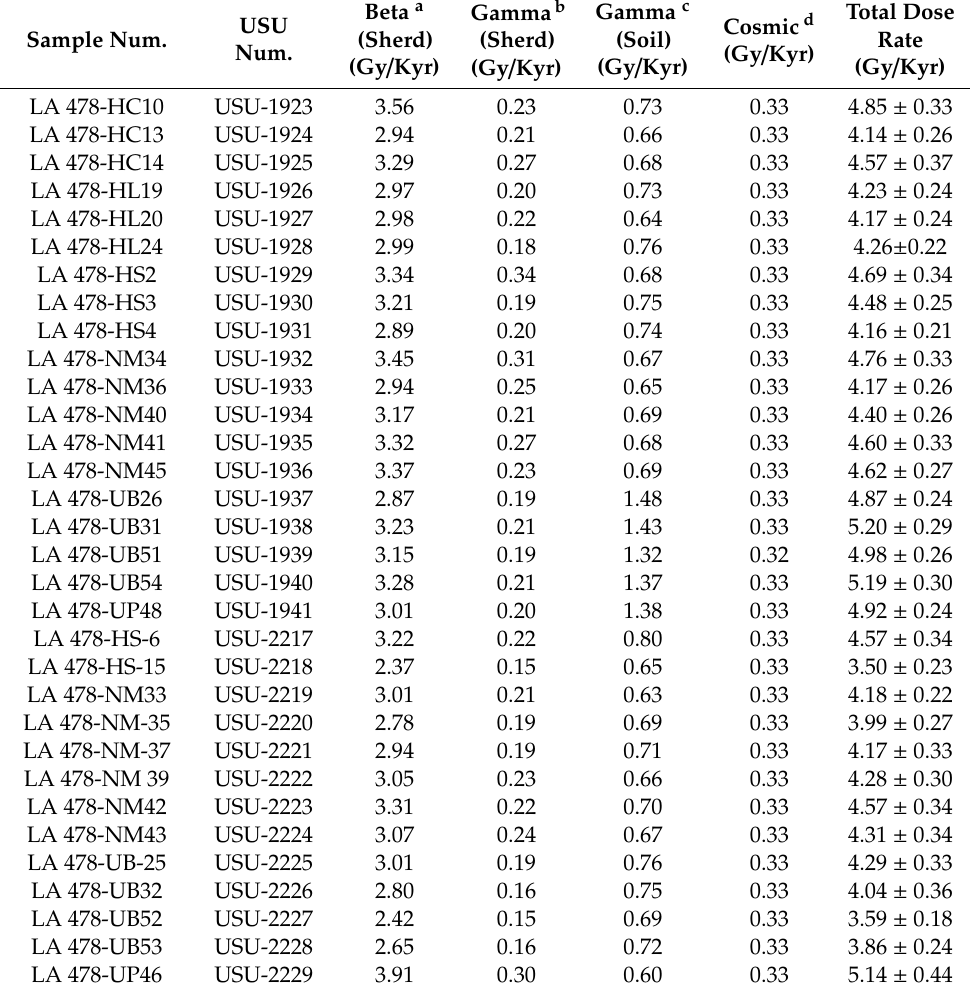
Table A4. Dose rate information for quartz analyses.